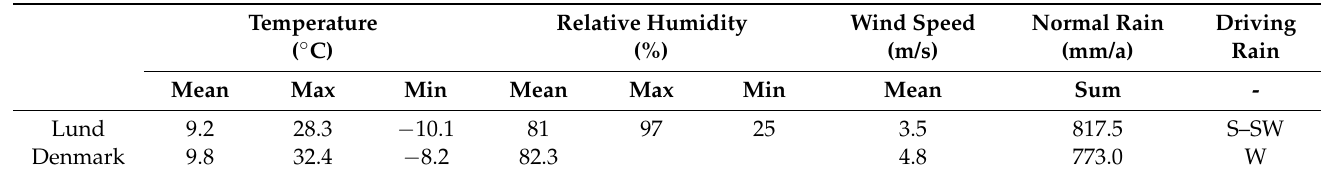
Table 3. Comparison of weather for Lund (WUFI file) and Denmark (year 2020) [20] where only mean relative humidity is presented.